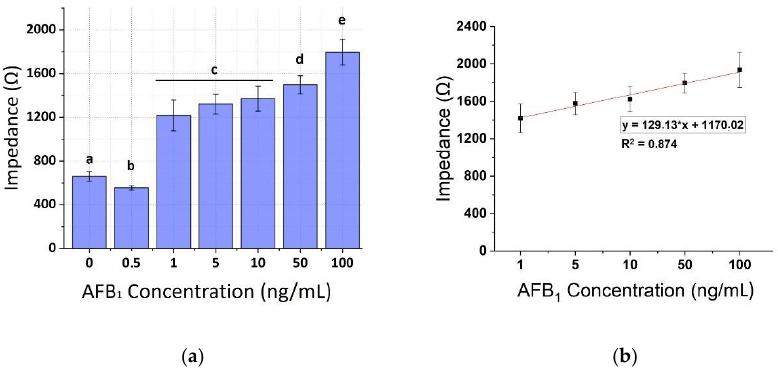
Figure 10. ( a ) Extracted results from the mean impedance magnitude values for different concentrations of AFB 1 spiked pistachio samples at 10 KHz ± STD. Different letters (a, b, c, d, e) indicate statistically significant different values ( p < 0,05). ( b ) Linear fit curve of the normalized values of the mean impedance magnitude for concentrations of AFB 1 spiked pistachio samples (1−100 ng/mL) tested at 10 KHz.